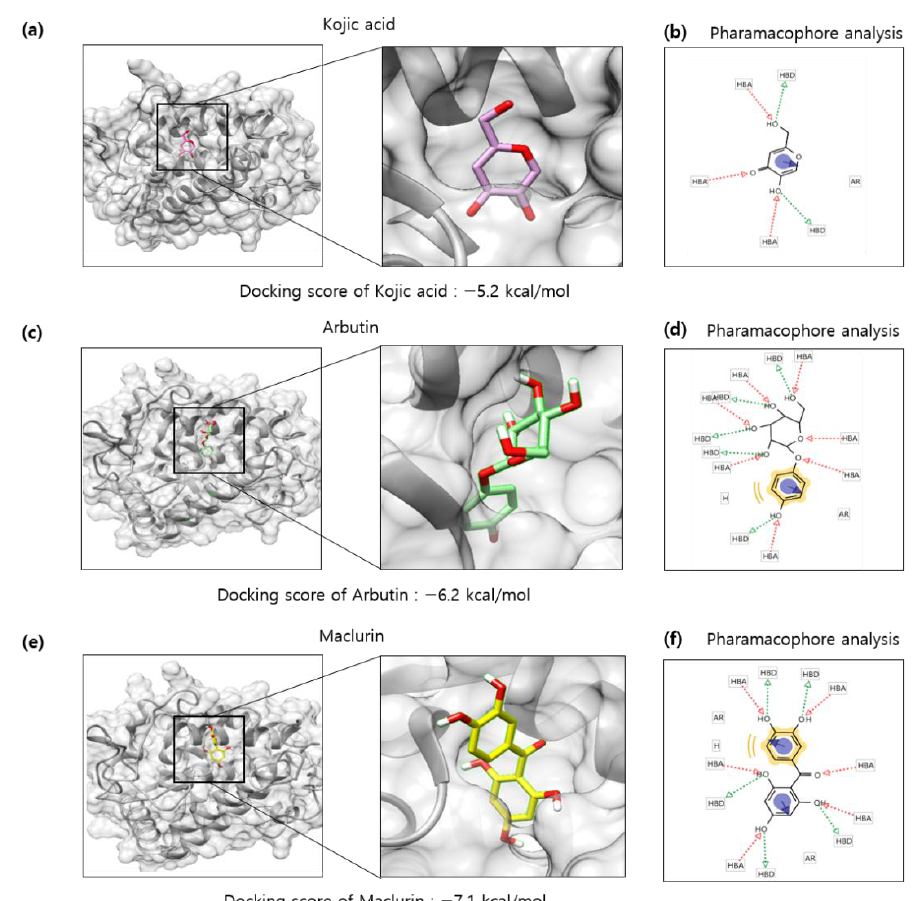
Figure 6. In silico docking simulation of tyrosinase and maclurin. Protein-ligand docking simulation was performed using AutoDock Vina. It was analyzed between human tyrosinase (5I38) and ( a ) kojic acid, ( c ) arbutin, and ( e ) maclurin as a receptor and ligands, respectively. In a marked square box, it represents the tyrosinase binding site with an enlarged image. The binding residues analysis of ( b ) kojic, ( d ) arbutin, or ( f ) maclurin with tyrosinase was performed by pharmacophore analysis.